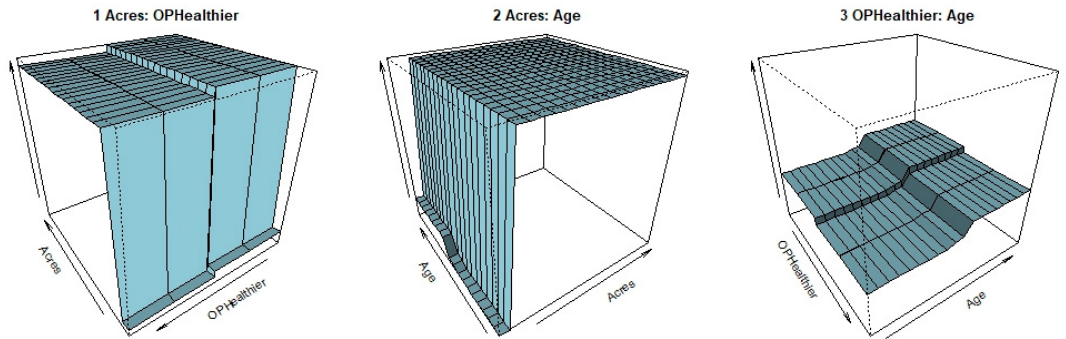
Figure 10. Interaction of variables for acres commitment model to produce.